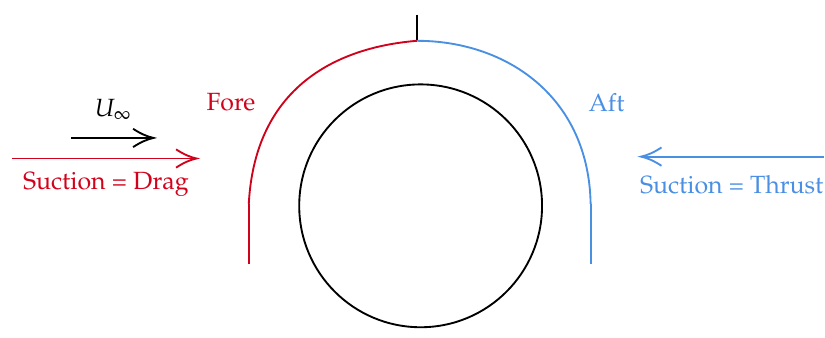
Figure 21. Wheel arch pressure